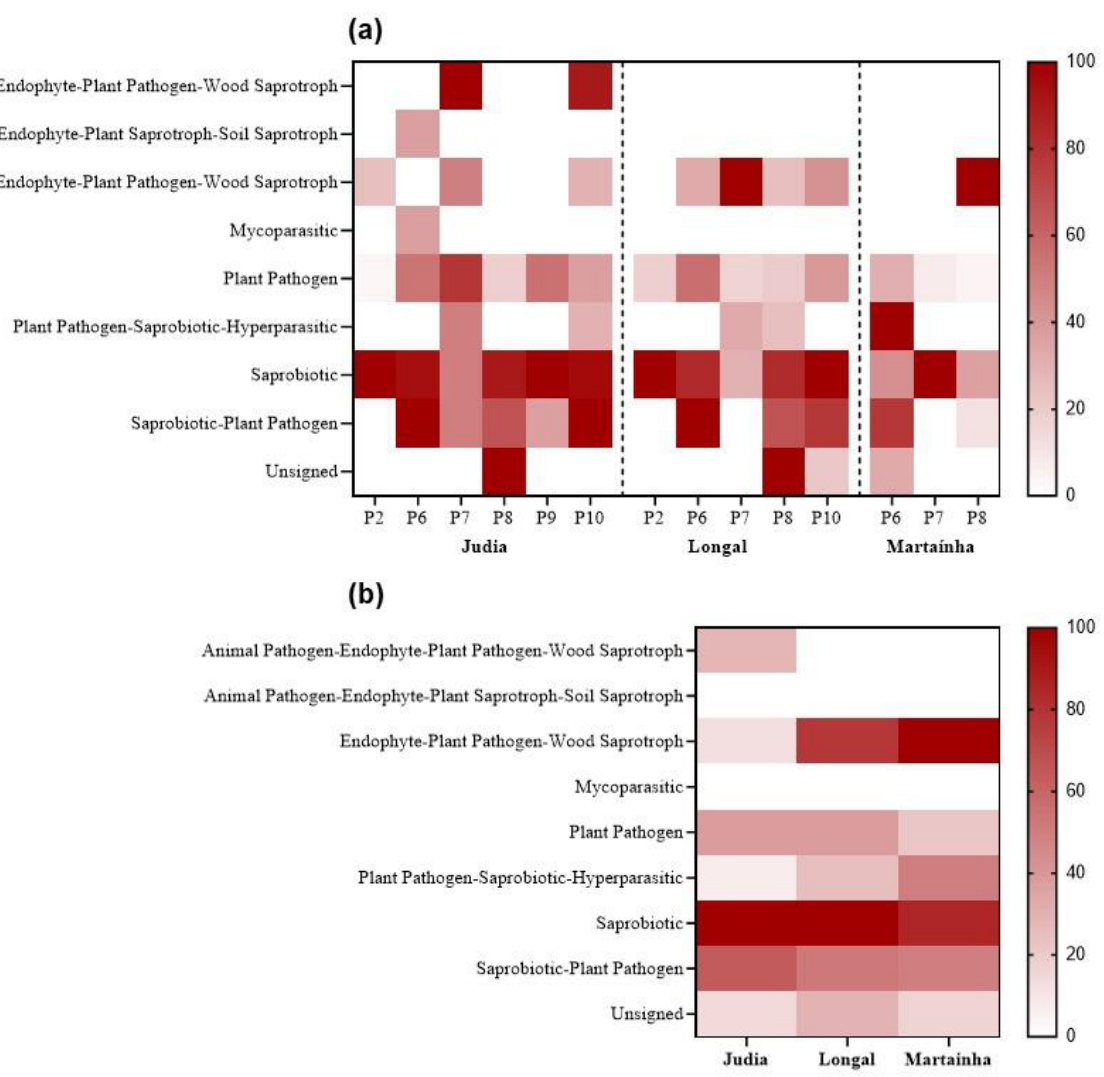
Figure 8. Heat maps of the frequency of the fungal guilds obtained ( a ) for each processing stage for the chestnut varieties (Judia, Longal and Martaínha); ( b ) per variety. the chestnut varieties (Judia, Longal and Marta í nha); ( b ) per